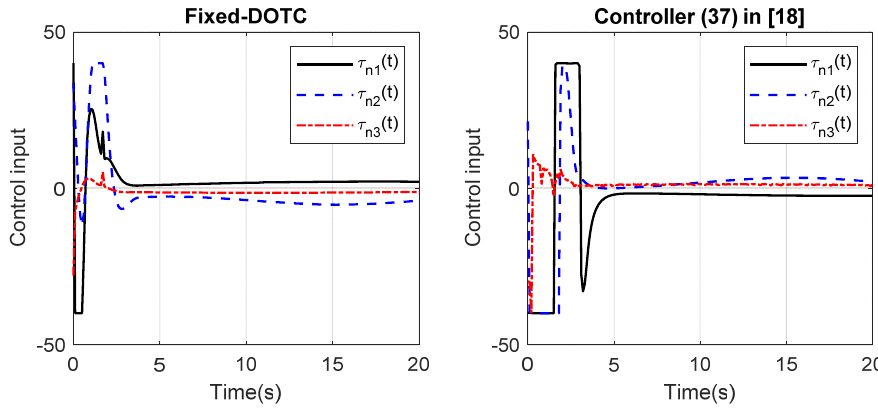
Figure 12. The control input in part 2.